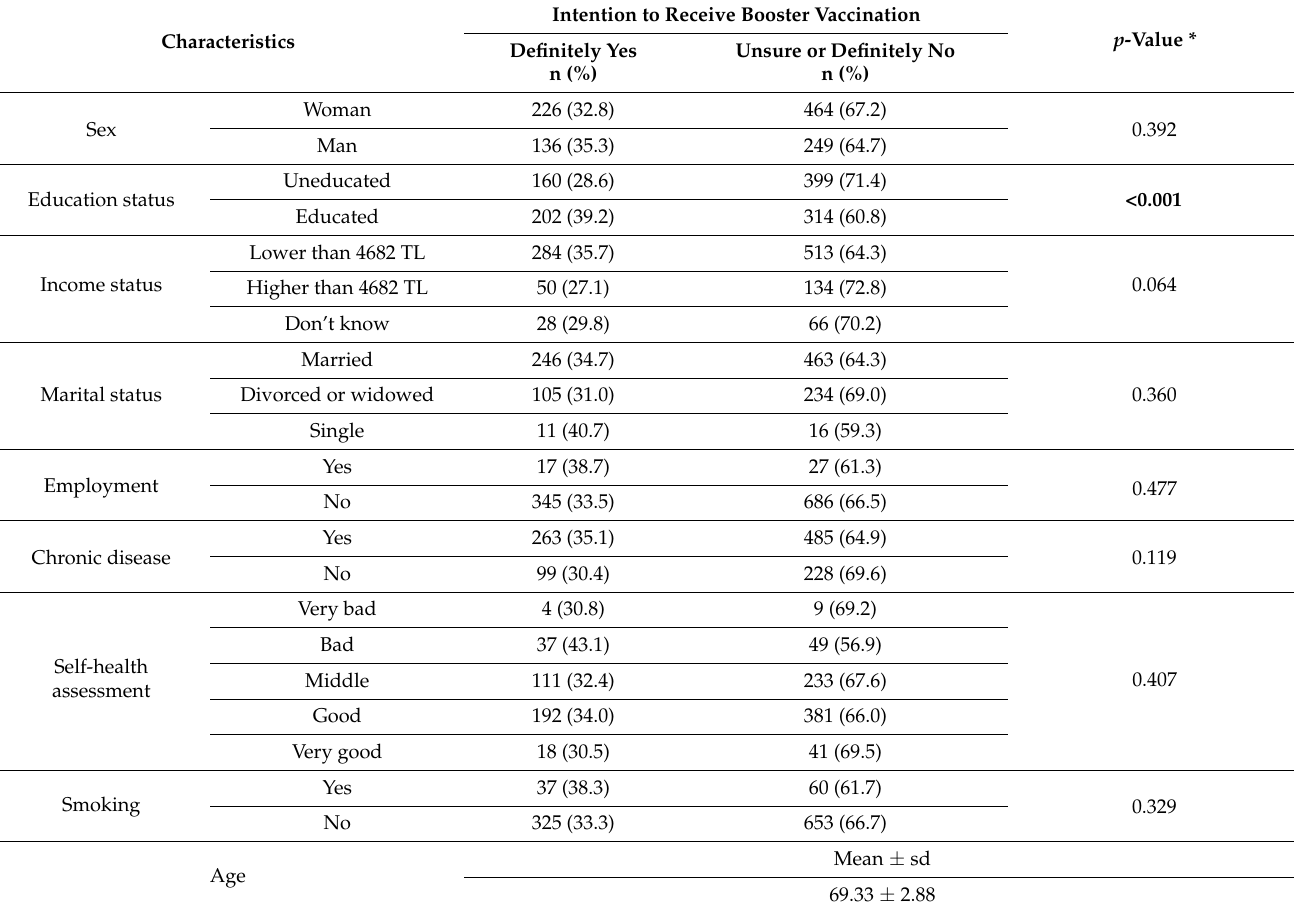
Table 2. Characteristics of participants by intention to receive the booster vaccination.